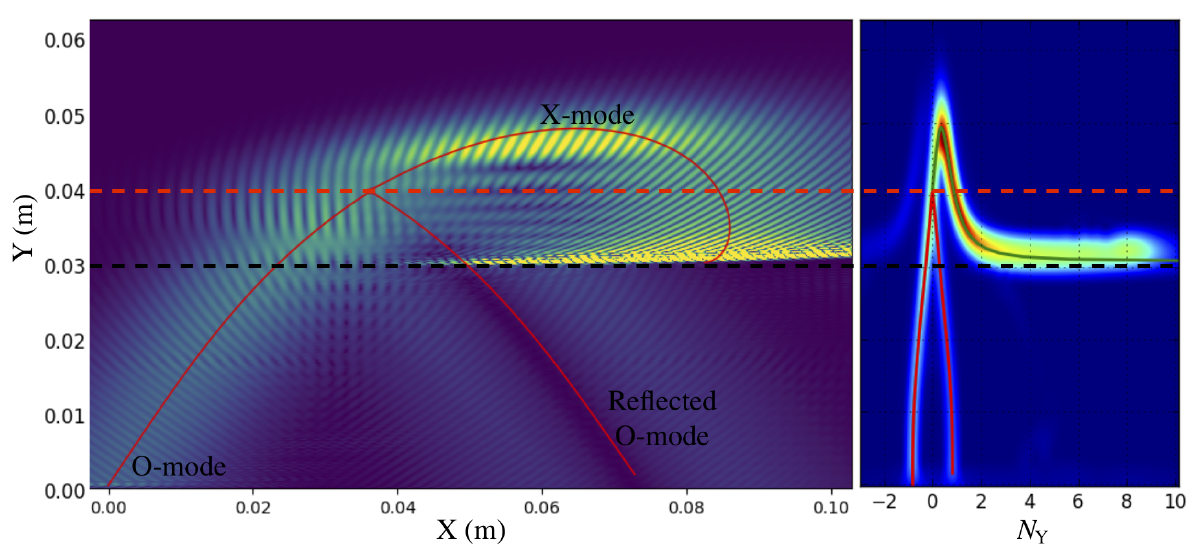
Figure 2. An example of an O-X mode conversion calculation. Left plot: snapshot of the wave electric field (color-coded), ray tracing (solid red). The antenna is located in the bottom left corner. The O-mode cuto ff and Upper Hybrid resonance layers are indicated with red and the black dashed lines, respectively. Right plot: windowed Fourier transform of the wave field, i.e wave refractive index (color-coded) and the refractive index predicted by ray-tracing